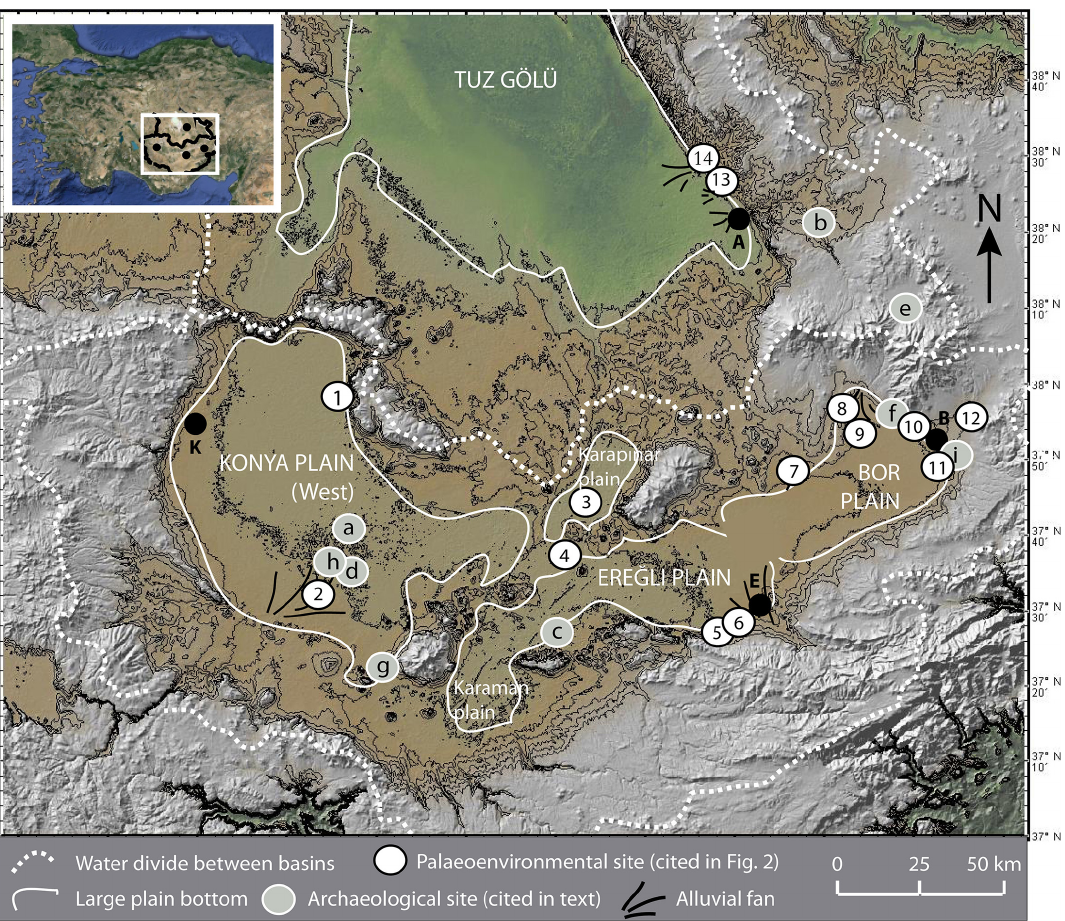
Figure 3. The main large plains of endorheic central Anatolia and location of sites cited in the text and in Fig. 7. Main cities: K, Konya; E, Ere˘gli; B, Bor; A, Aksaray. Palaeoenvironmental sites: 1, Yarma (Kuzucuo˘glu et al., 1999); 2, Çarsamba fan (Boyer et al., 2006);